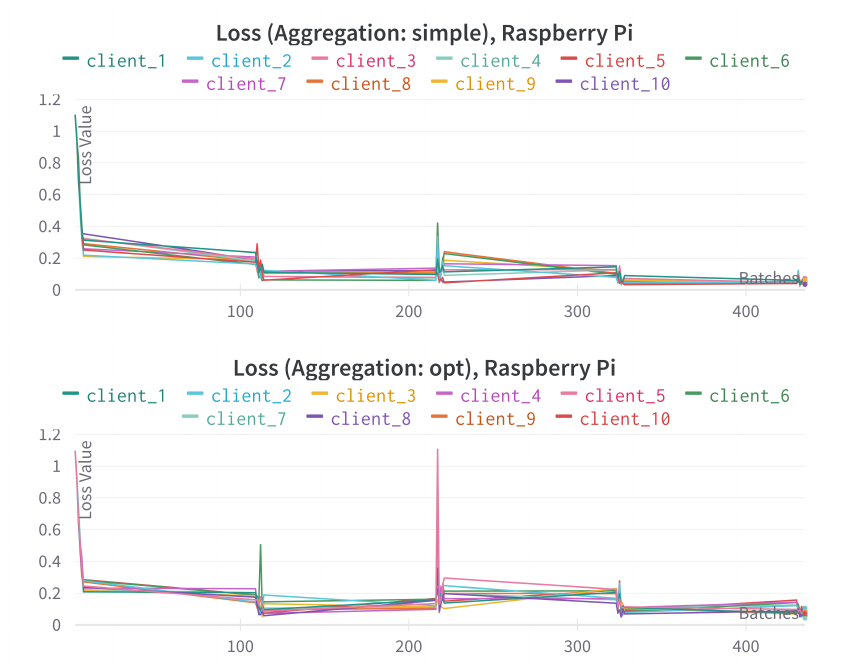
Figure 6. Loss comparison for different federated aggregation techniques using 10 Raspberry Pi devices. The x-axis represents the incremental number of training mini-batches, the y-axis represents